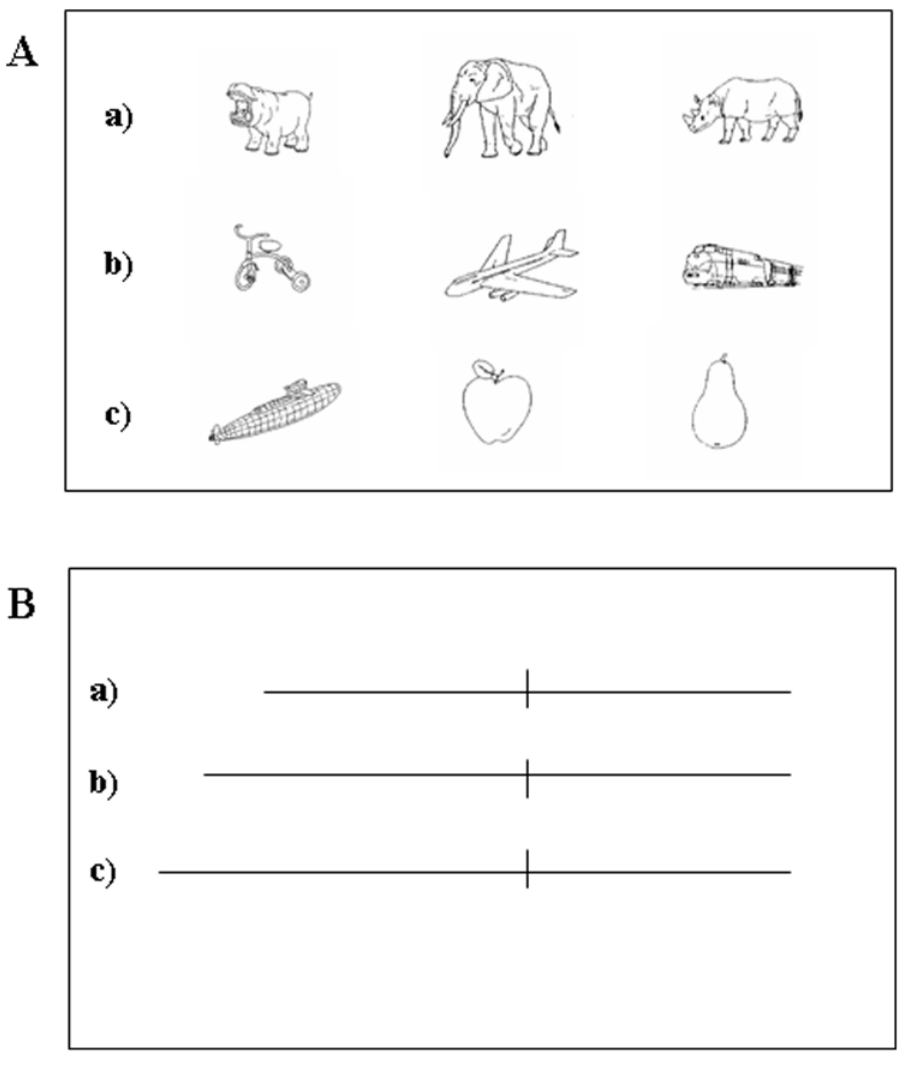
Figure 1. Schematic of the experimental design showing sample stimuli and experimental conditions. (A) Example stimuli of 1) Near within-category condition; 2) Same condition; 3) Near across-category condition in the Semantic distance judgment task; (B) Example stimuli of 1) Near within-category condition 2) Same condition 3) Near across-category condition in the Spatial judgment task.